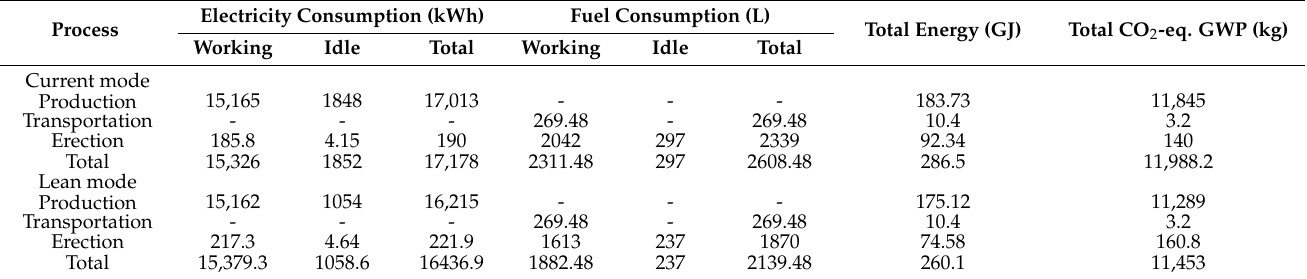
Table 8. Total consumption of energy and emission of carbon dioxide